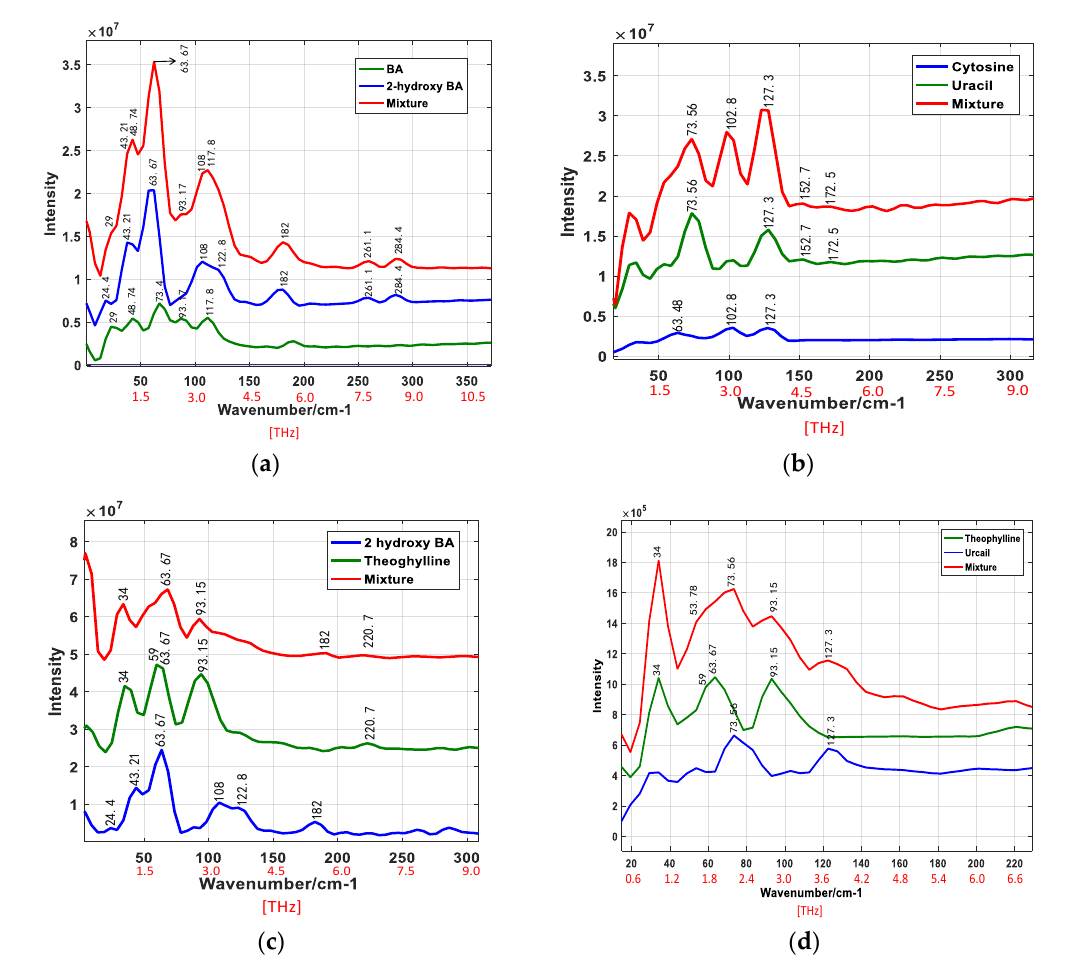
Figure 10. ( a ) THz Raman spectra of BA powder and 2-hydroxy BA at a laser power of 128 mW with an integration time of 50 s. ( b ) THz Raman spectra of cytosine powder and uracil powder at a laser power of 128 mW with an integration time of 50 s. ( c ) THz Raman spectra of 0.1 mol/L 2-hydroxy BA aqueous solution and 0.1 mol/L theophylline aqueous solution (ratio 1:5) at a laser power of 128 mW with an integration time of 100 s. ( d ) THz Raman spectra of 0.1 mol/L theophylline aqueous solution and 0.1 mol/L uracil aqueous solution (ratio 2:1) at a laser power of 128 mW with an integration time of 100 s.